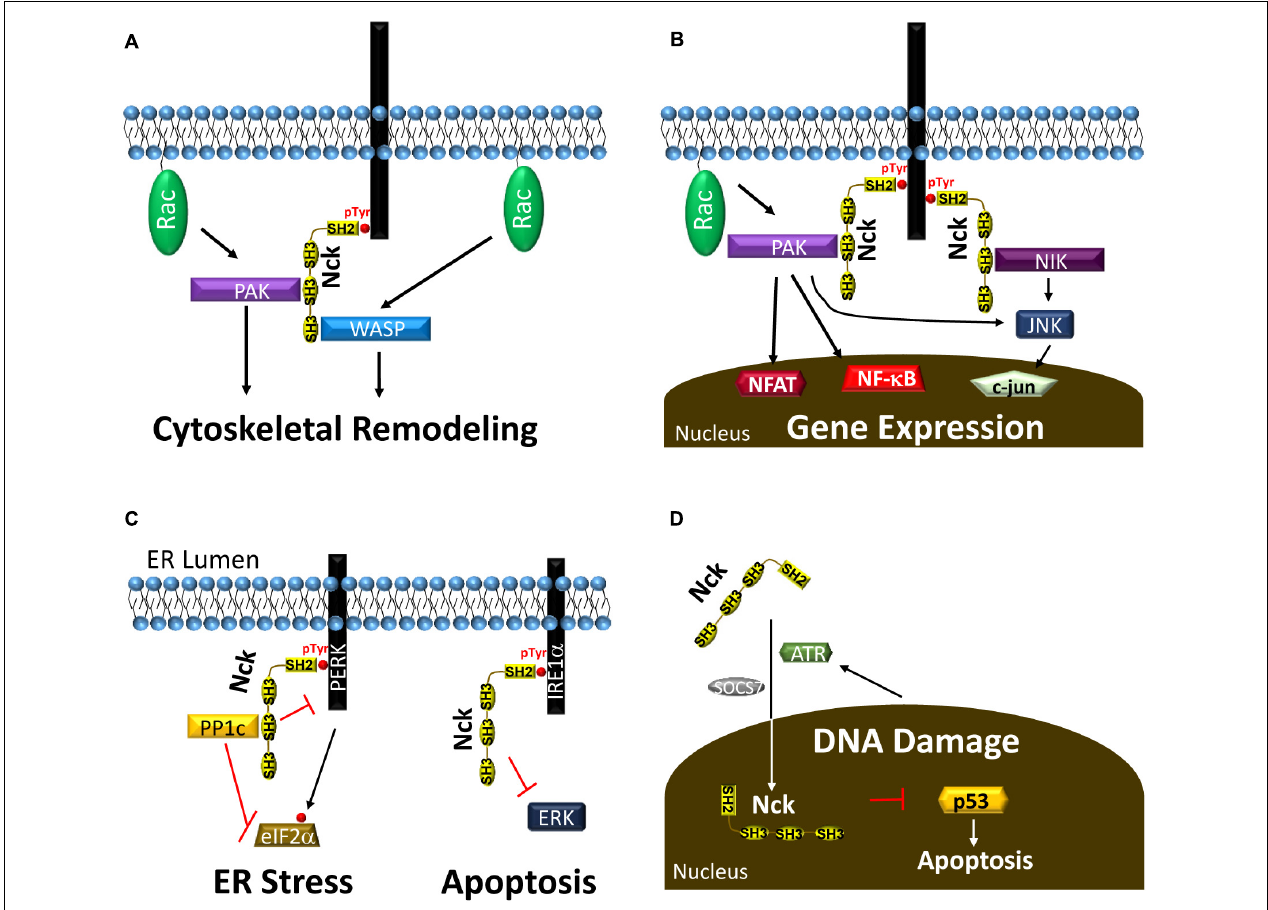
FIGURE 3 | (A) Nck recruitment to tyrosine phosphorylated proteins recruits PAK and WASP to enhance their activation by the small GTPase RAC, leading to cytoskeletal remodeling and cell migration. (B) Nck recruitment to phosphotyrosine enhances activation of several proteins, such as PAK and NIK, that activate transcription factors to affect gene expression. (C) Nck1 recruitment to the ER membrane through interactions with PERK and IRE1 α reduces ER stress and ER stress-associated apoptosis. (D) ATR and SOCS7 drive Nck translocation into the nucleus following DNA damage to reduce p53-dependent